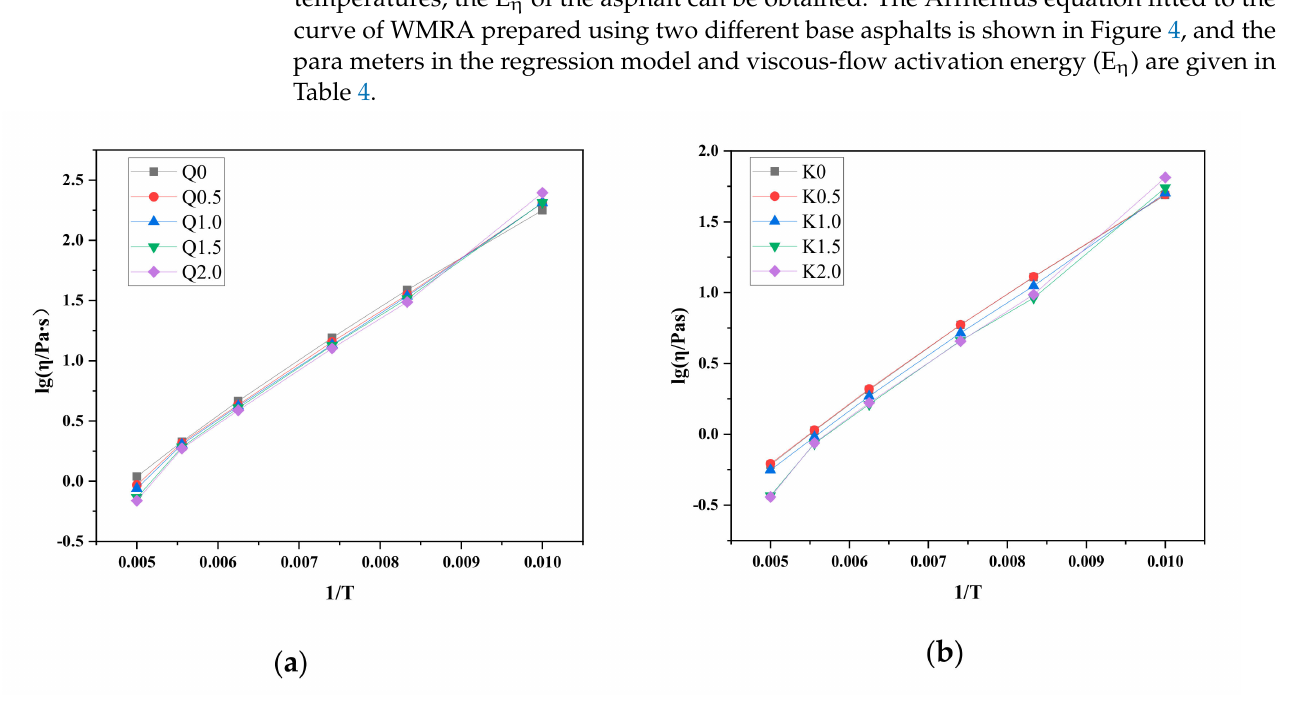
Figure 4. Arrhenius equation fitting curve of warm mix rubber asphalts: ( a ) QS; ( b ) KS. Table 4. Fitting results of Arrhenius equation for warm mix rubber